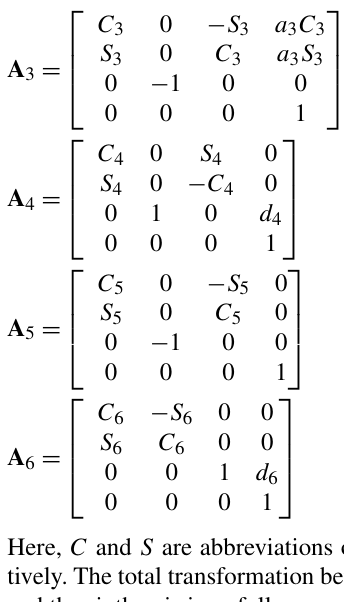
Table 1. DH parameters of the Denso robotic arm,